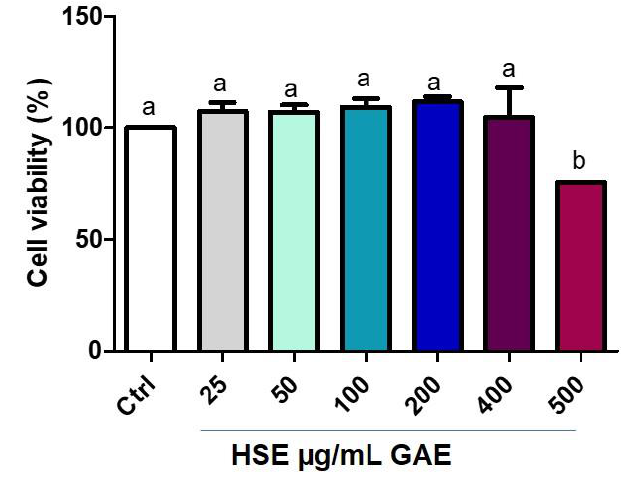
Figure 3. Cell viability after HSE treatment on THP-1 macrophages (M0). The MTT assay was performed at 24 h post-treatment. Cell viability was expressed as % of control (non-treated). All data represent the means of at least three replicates ± standard deviation. The analysis of variance was carried out using one-way ANOVA followed by the Tukey’s multiple comparison test: letters denote significant differences among samples.